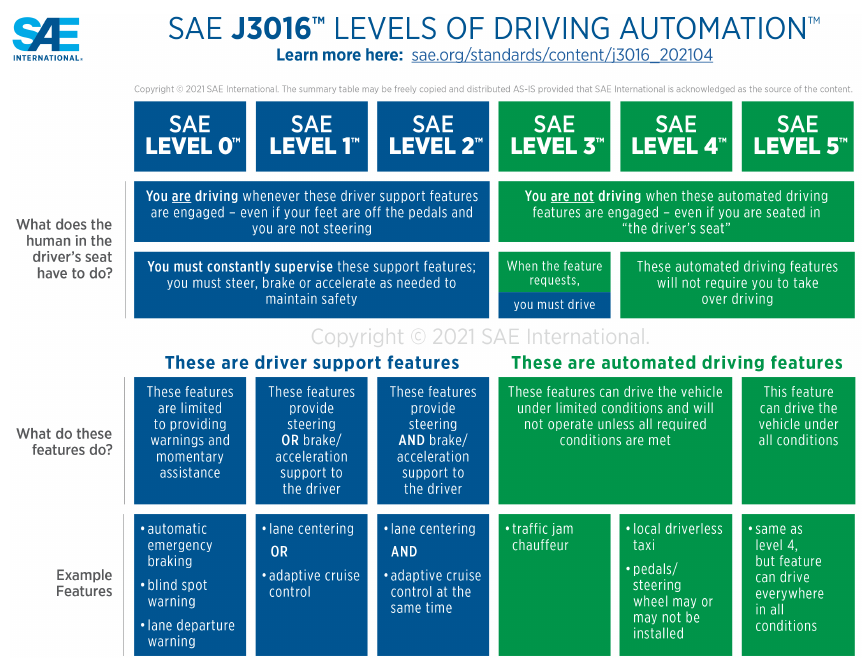
Figure 1. Levels of Driving Automation as defined by SAE J3016, revised in 2021. Source